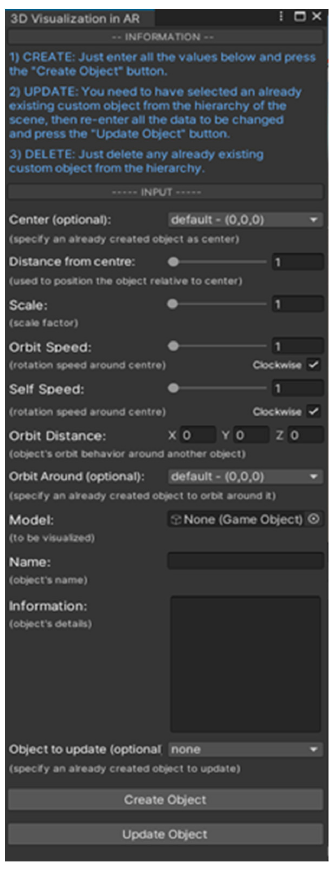
Figure 7. Proposed system’s editors.